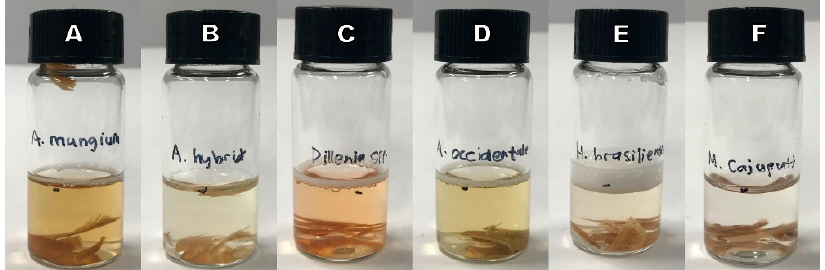
Figure 9. Froth tests of Acacia mangium ( A ), Acacia hybrid ( B ), Dillenia pentagyna ( C ), Anacardium occidentale ( D ), Hevea brasiliensis ( E ), and Melaleuca cajuputi ( F ). As reported by the IAWA committee [27], the heartwood of Anacardium spp. shows yellow or green fluorescence, which is in line with the results of the present study.